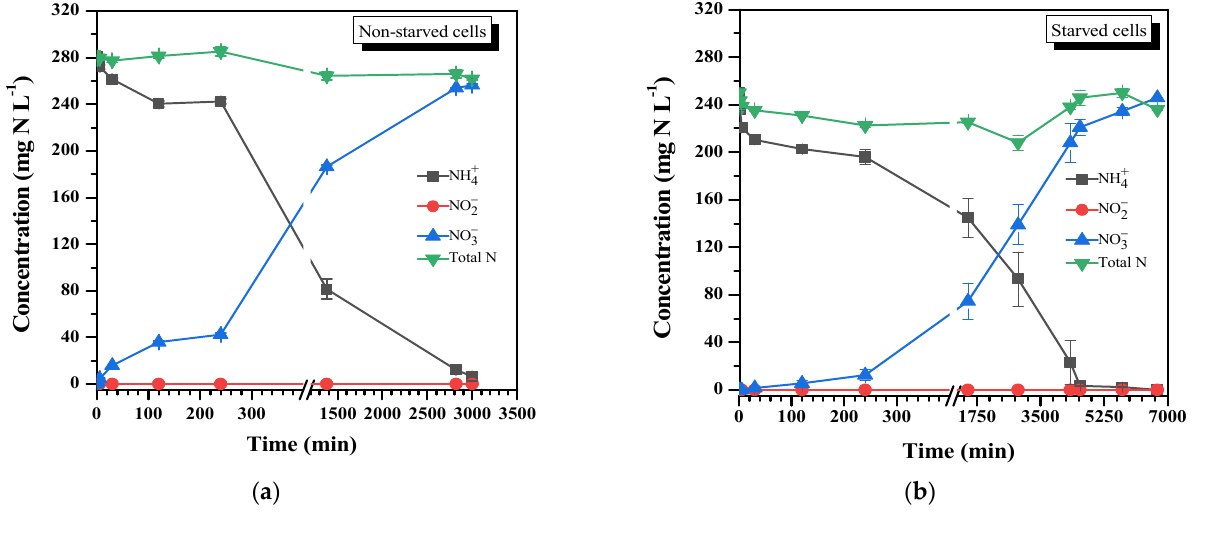
Figure 2. The process of nitrification performed by non-starved ( a ) and 3-day-starved ( b ) cells of enriched nitrifying cultures. Incubation conditions included temperature of 25 °C, initial NH 4+ -N concentration of 250 mg N L − 1 , and cell density of 500 mg TSS L − 1 , equivalent to 1.29 × 10 9 cells mL − 1 .